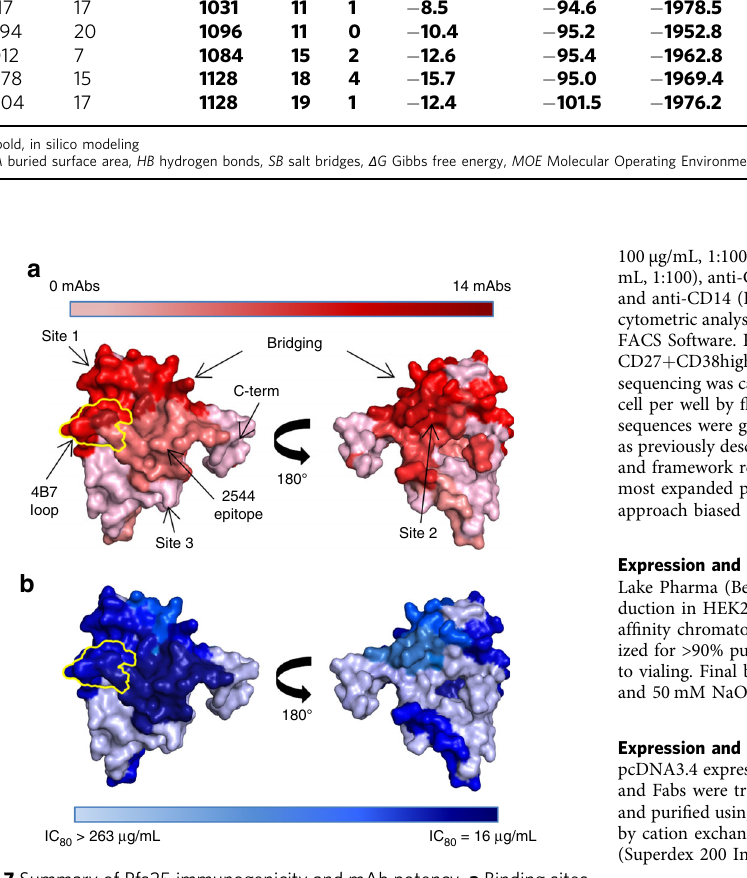
Fig. 7 Summary of Pfs25 immunogenicity and mAb potency. a Binding sites on Pfs25 of mAbs isolated from a human donor and previously isolated from Kymice 27 . Pfs25 sites are delineated according to canonical binders for which crystal structures are known: 1269 for Site 1a, 2544 for Site 1b, 1260 for Site 2, 2586 for bridging, and 2530 for Site 3. Residues of Pfs25 are colored according to the quantity of mAbs expected to bind that residue from BLI competition experiments. The darker the red, the greater the immunogenicity on Pfs25. The loop on Pfs25 recognized by murine 4B7 is highlighted in yellow. b Surface representation of potency for anti-Pfs25 mAbs isolated from a human donor and Kymice 27 . Pfs25 sites are delineated as in a , and residues colored according to mAb potency (IC 80 ). If more than one mAb was present in an epitope bin, an average of the IC 80 s was used. The darker the blue, the higher the potency of mAbs against this site in